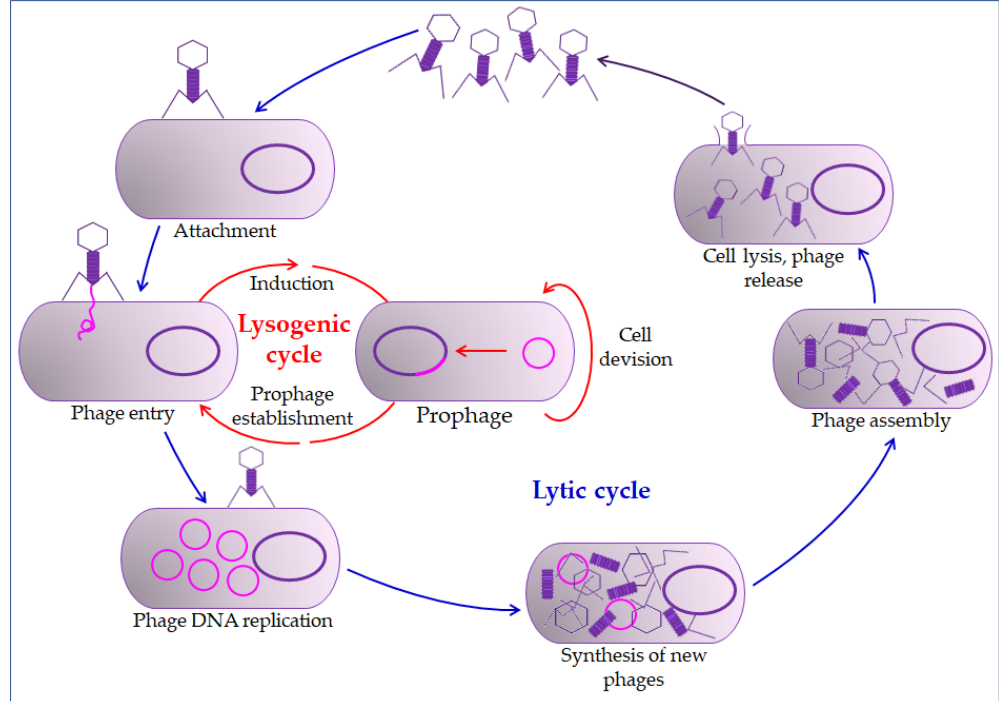
Figure 2. Bacteriophage life cycle. The bacteriophage first interacts with receptors on the host, absorbs, and then injects its genome to infect a bacterium. The lytic cycle involves the production of new bacteriophages and their release from the infected cell by lysis. The lysogenic cycle results in integrating a phage genome into the bacterial genome, which replicates in concert with the host DNA.